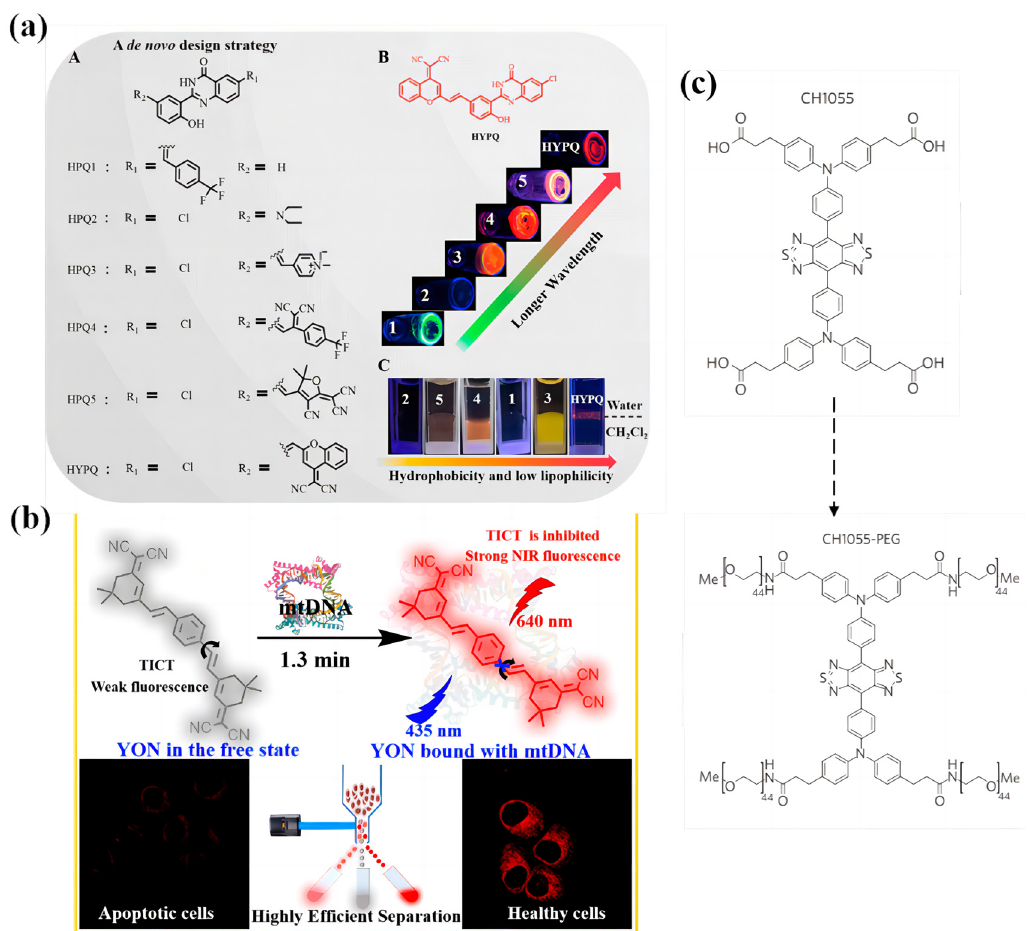
Figure 9. ( a ) The design of hydrophobicity and low lipophilicity NIR solid ‐ state fluorochrome. (A) A de novo design strategy for developing solid ‐ state fluorophores. (B) Solid ‐ state fluorescent photographs of those fluorophores in the powder samples. (C) Diffusion experiments were conducted at the interface between water and dichloromethane (amphiphilic environment). All fluorescent photos were obtained under UV lamp excitation at 365 nm. Adapted with permission from [75]. ( b ) The binding of YON to mtDNA. Adapted with permission from [82]. ( c ) The chemical structure of CH1055 and the one ‐ step synthesis of CH1055 ‐ PEG. Table 2. The important parameters for hydrogen bonding and the D-A system strategy in AIE probes.